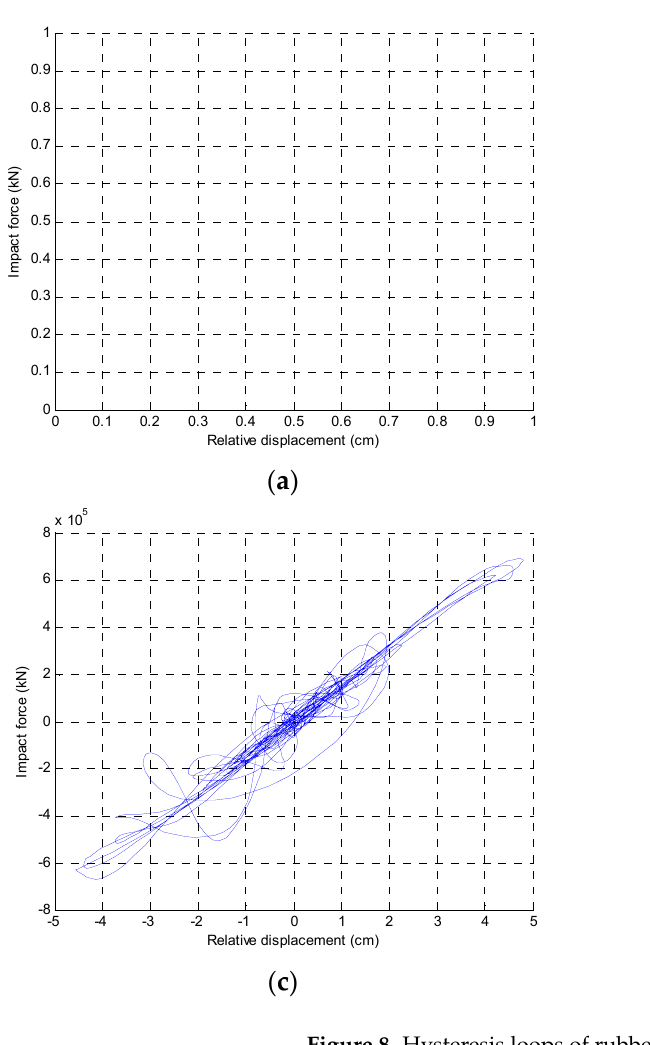
Figure 8. Hysteresis loops of rubber bumpers during impact: ( a ) base level; ( b ) first story; ( c ) second story; ( d ) third story.